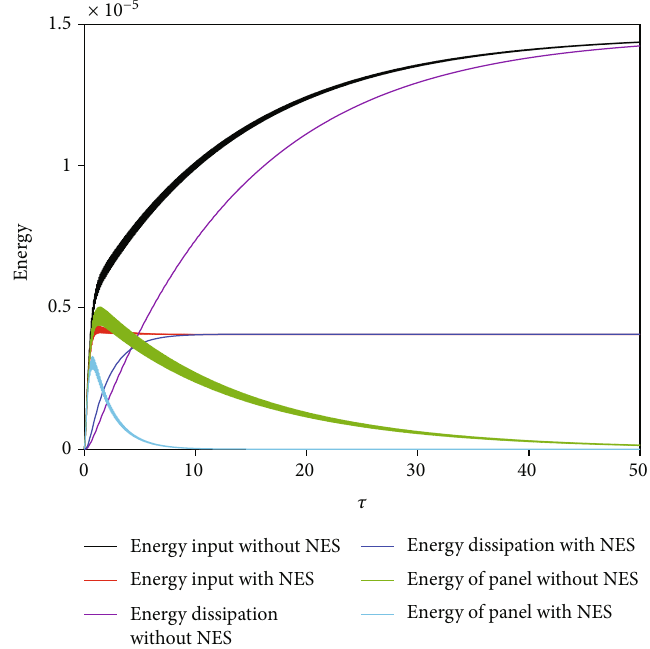
Figure 5: Time history of